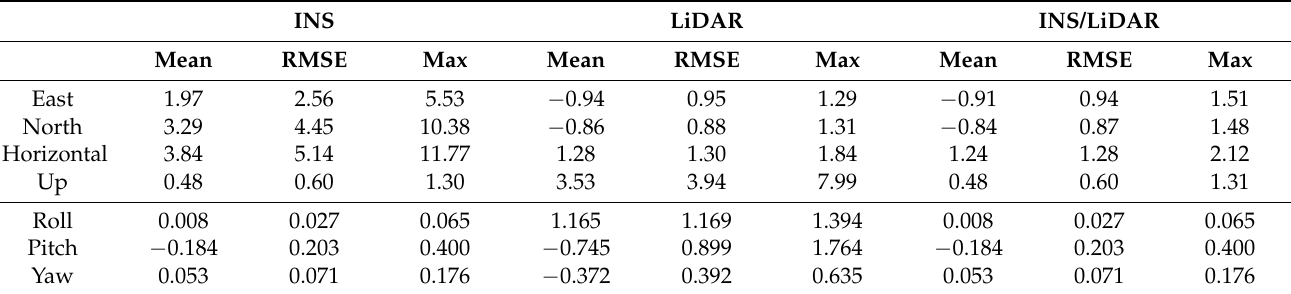
Table A19. D-15—position (m) and attitude (deg) error statistics.